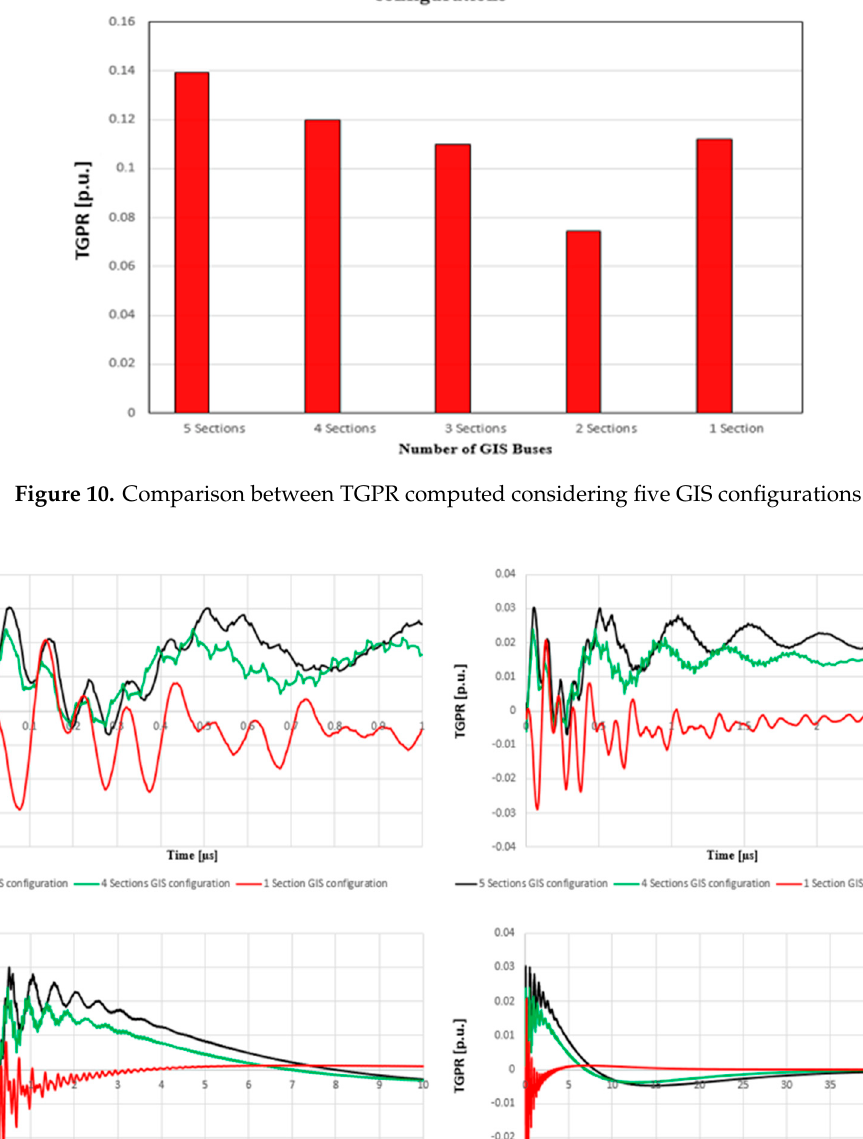
Figure 10. Comparison between TGPR computed considering five GIS configurations.